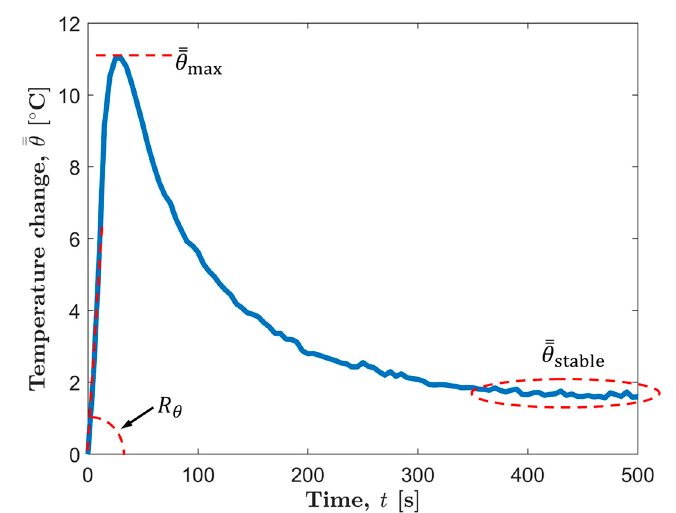
Figure 9. Thermal indicators for fatigue limit evaluation.